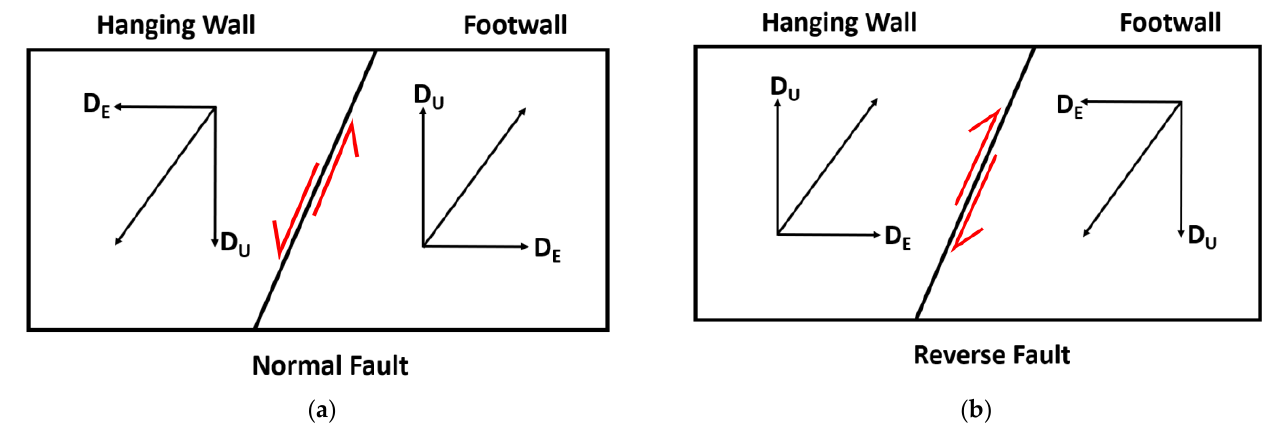
Figure 5. The schematic illustrations of ( a ) normal fault and ( b ) reverse fault.